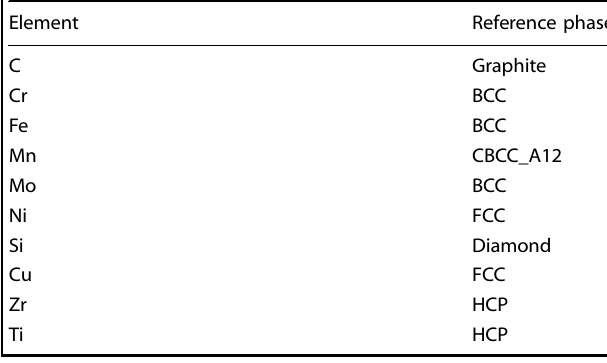
Table 3. List of reference phases used for each element in the activity modeling in Pandat.